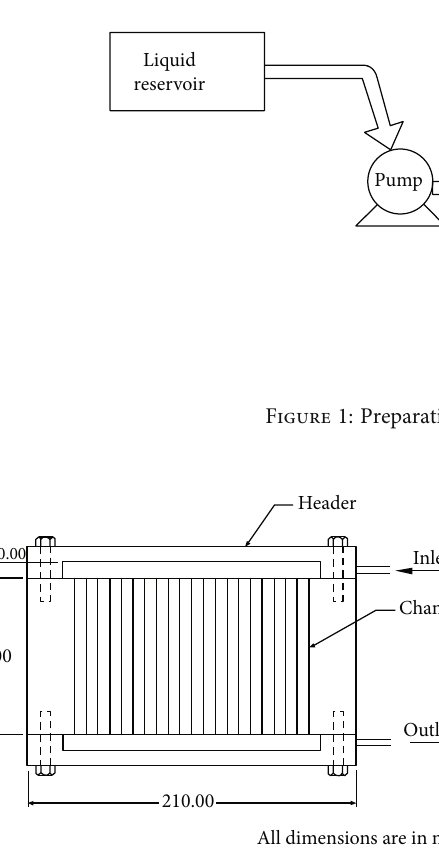
Figure 2: Preparation of nano fl uid using an ultrasonic bath.